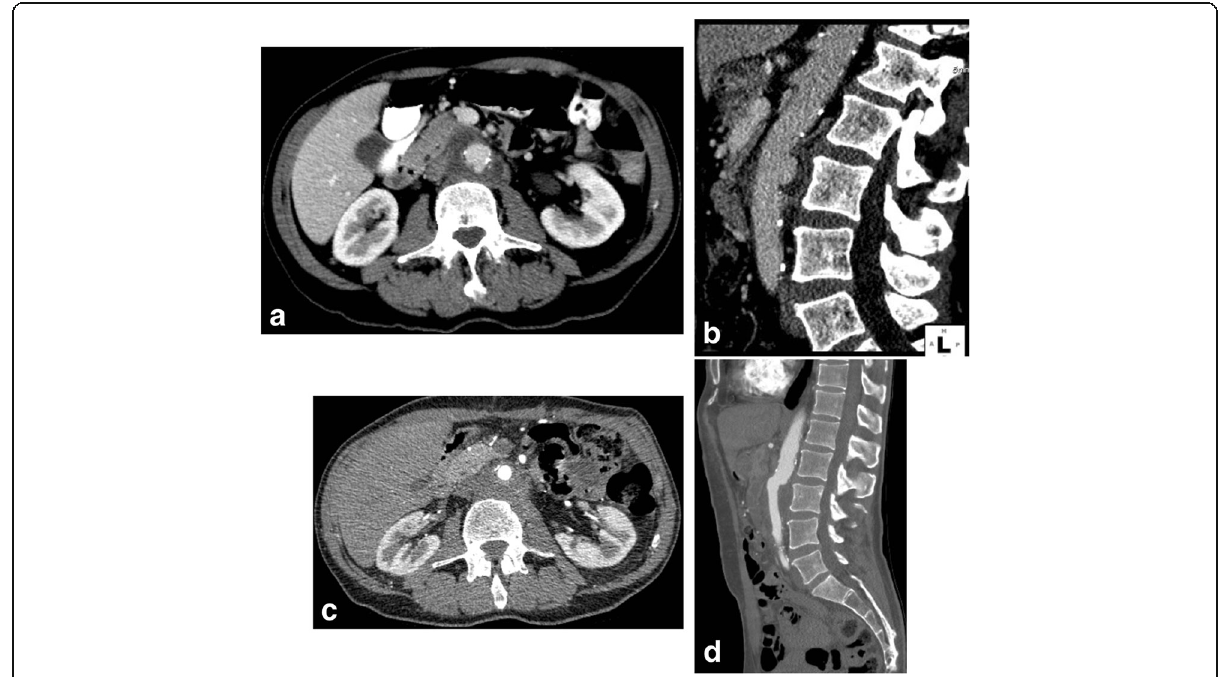
Fig. 2 Seventy three year old male with mycotic aneurysm of the abdominal aorta. a Axial and b sagittal images of a portal venous phase exam showing peripherally enhancing hypoattenuating periaortic mass with a focal out pouching arising from the posterior wall of the aorta consistent with a psuedoaneurysm. Post-surgical repair c axial and d sagittal images of CTA show unremarkable superficial femoral vein graft with no residual